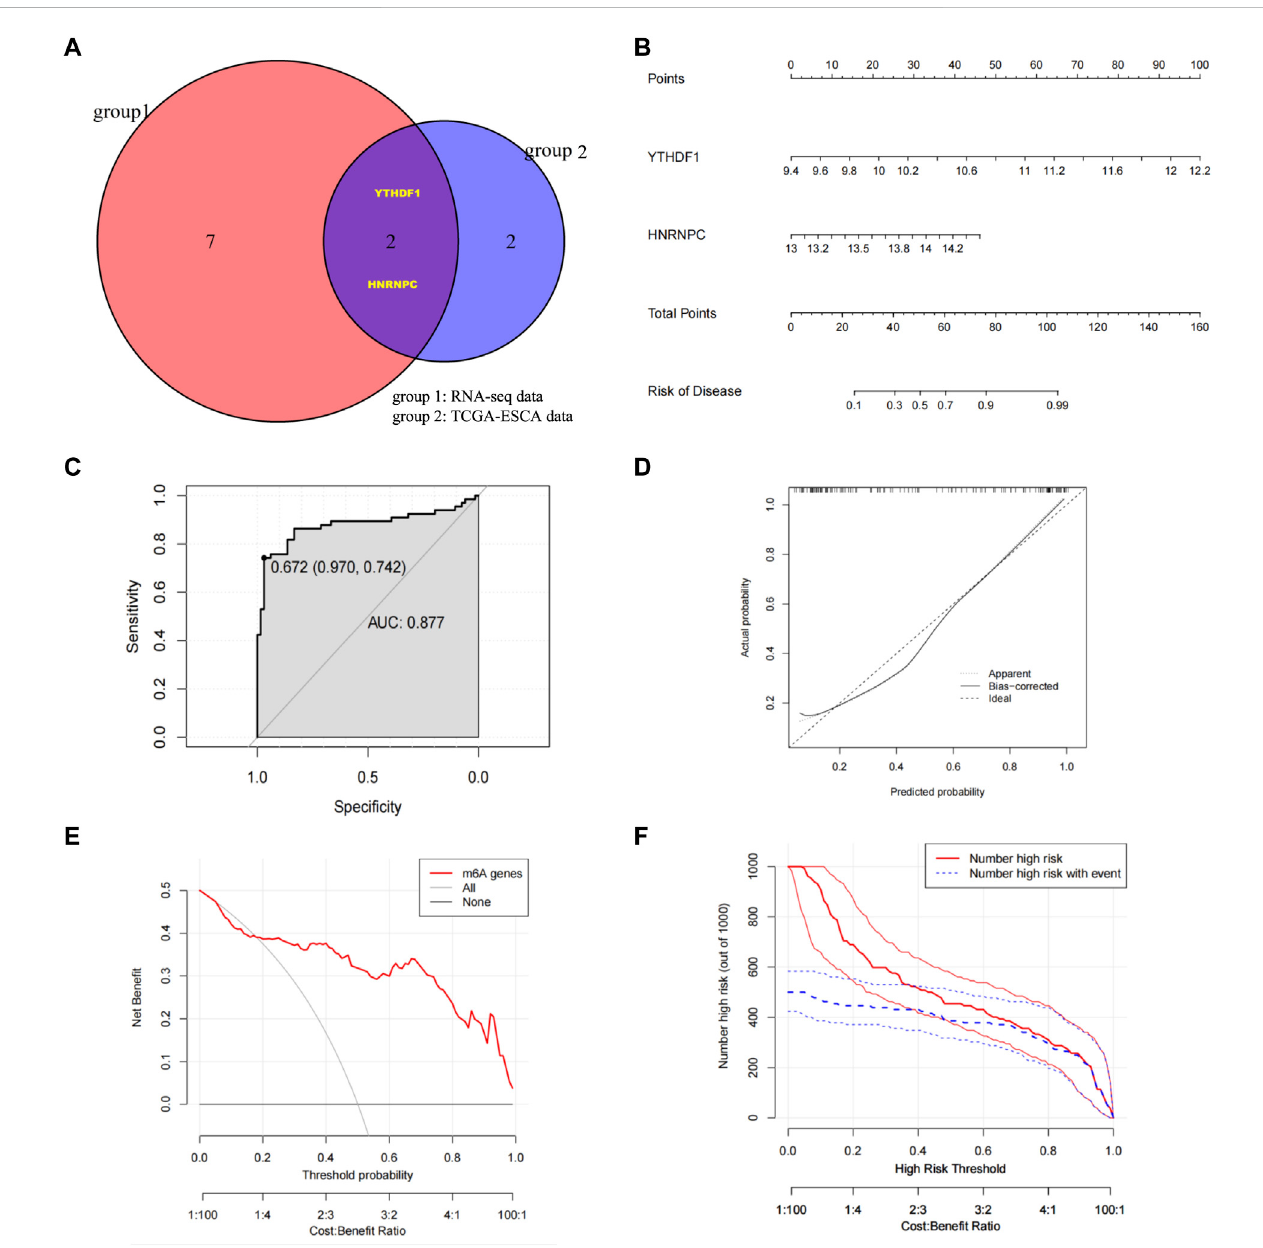
FIGURE 4 Identify ESCC-related m6Aregulators, buildrisk models, and validatemodel predictivecapabilities (A) Venn diagrams determined YTHDF1 and HNRNPC as ESCC risk factors after overlapping m6A regulators with higher meanDecreaseGini score in both RNA-seq data and TCGA-ESCA database. (B) Nomogram was constructed using YTHDF1 and HNRNPC to visualize the predictive ability of ESCC-related m6A regulators for Normal group and ESCC group. (C) Calibration curve with nomogram predicted probabilities on the x-axis and actual probabilities on the y-axis. The dashed line represents the true value, andthesolidlineisbias-correctedbyBootstrapping(1000repetitions). (D) ROC curvewasapplied toassess thepredictiveef fi ciencyofthemodel. (E) Clinical decision curve. The red line represents the outcome predicted by the model, the grey line represents “ all positive diagnosis (ESCC) ” and the black line represents “ all negative diagnosis (Normal) ” . The horizontal axis is Threshold Probability, and the vertical axis is the net pro fi t rate after subtracting the disadvantages. (F) Clinical Impact Curve (CIC). The red curve (Number of high risk) represents the number of people classi fi ed as ESCC by the model at each threshold probability; the blue curve (Number high risk with outcome) represents the number of true ESCC at each threshold probability. AUC, Area Under Curve; CIC, Clinical Impact Curves; ESCC/ESCA, Esophageal quamous cell carcinoma; HNRNPC, RNA-binding protein, is a member of the heterogeneous ribonucleoproteins C; m6A, N6-methyladenosine; TCGA, The Cancer Genome Atlas; YTHDF1, YTH N6-methyladenosine RNA-binding protein 1.